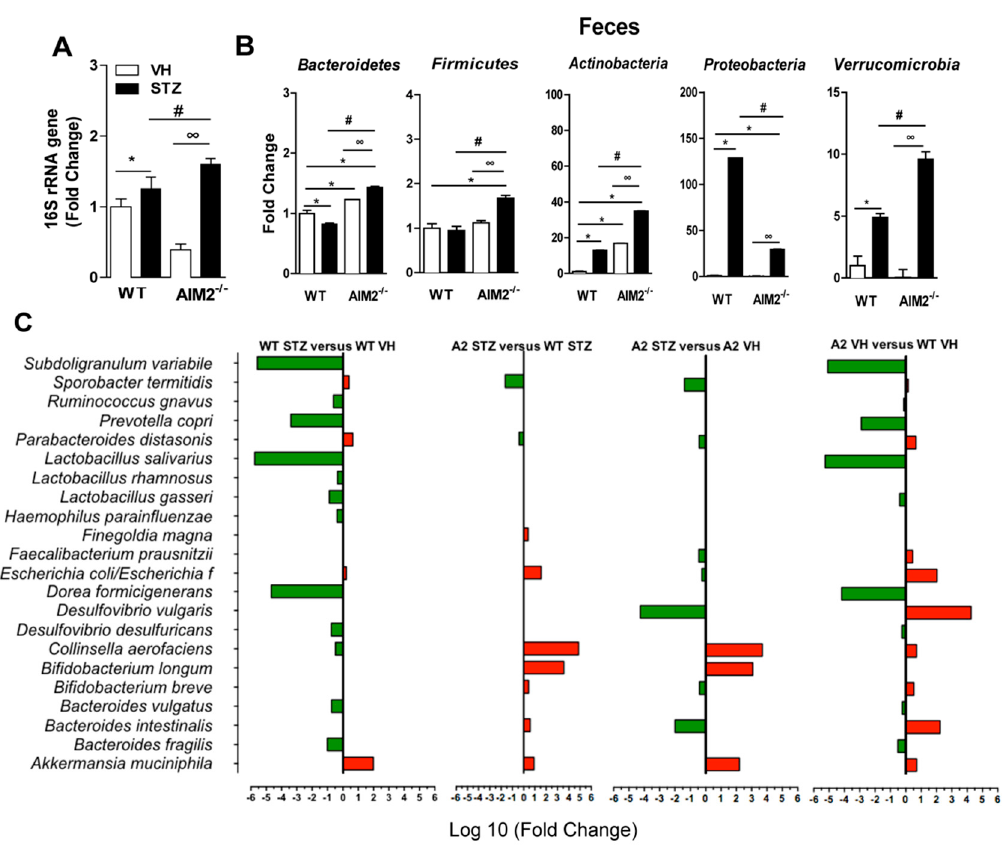
Figure 4. AIM2 receptor controls gut microbiota translocation to PLNs during T1D. The vehicle (VH)- or STZ-injected WT and AIM2 − / − mice were killed, and the PLNs were collected for the analysis of bacterial translocation by the 16S rRNA gene expression using qPCR. ( A ) The 16S rRNA gene expression in the PLNs of the WT and AIM2 − / − mice at 0 and 15 days after the STZ injections. ( B ) The gene expression of the bacteria from Bacteroidetes, Actinobacteria, Firmicutes, Proteobacteria and Verrucomicrobia phyla in the feces of the WT and AIM2 − / − mice at 15 days after the injection of the vehicle or STZ. ( C ) PCR array representing the gene expression of the bacterial species in the feces of the WT and AIM2 − / − mice at 15 days after the injection of vehicle or STZ. The values are expressed as the mean ± SD or log10 (fold). The results are considered statistically significant when p < 0.05 (*; #, ∞ ). N = 3–6 animals per group. Significant di ff erences between the groups were determined by one-way ANOVA, followed by Tukey’s multiple-comparison test.